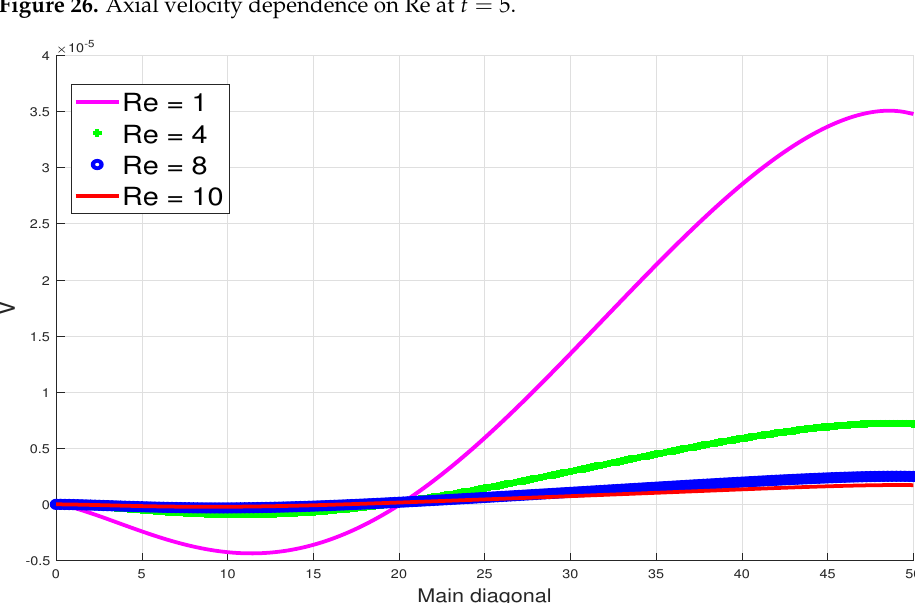
Figure 27. Transverse velocity dependence on Re at t =